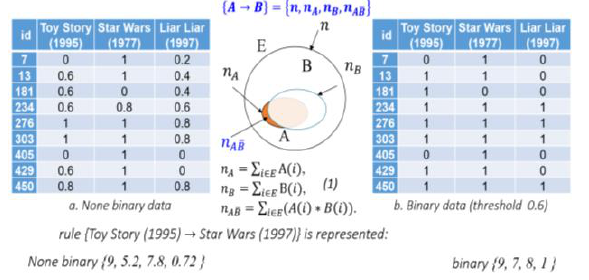
Figure 2. Demonstration of statistical implication relationships: ( 𝐴 → 𝐵) = { 𝑛, 𝑛 𝐴 , 𝑛 𝐵 , 𝑛